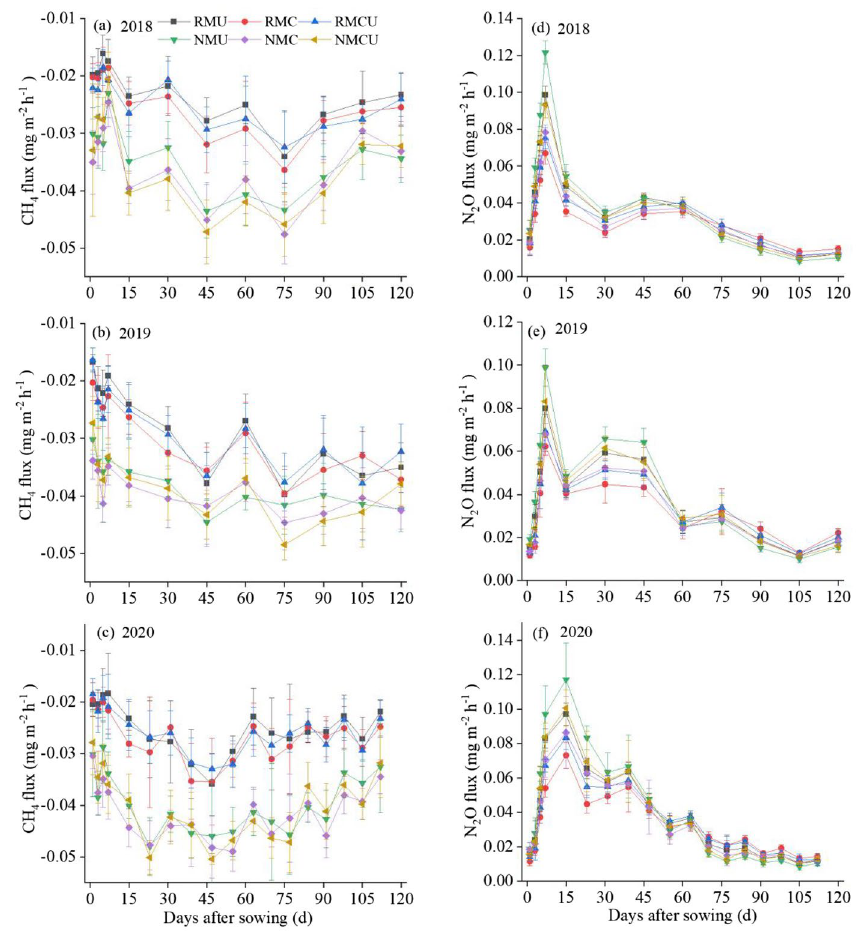
Figure 2. Dynamics of soil CH 4 fluxes ( a – c ) and N 2 O fluxes ( d – f ) under different treatments in 2018–2020 growing seasons. RM plastic film mulching, NM no plastic film mulching, U conventional urea, C